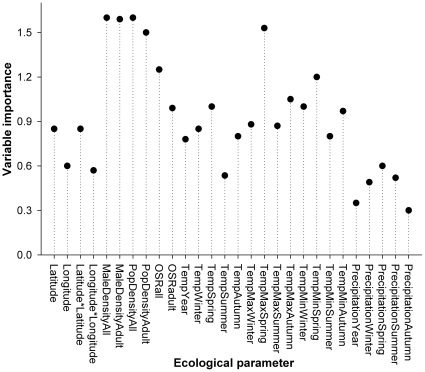
Variable importance plot of the partial least squares (PLS) regression explaining spatial variation in morph frequencies.Conform the CART analysis, mature male density and maximum spring temperature were selected as most important explanatory variables. Note that all density estimates are highly correlated (all R2>0.9). Hence, only adult male density is used in further analyses (see methods).